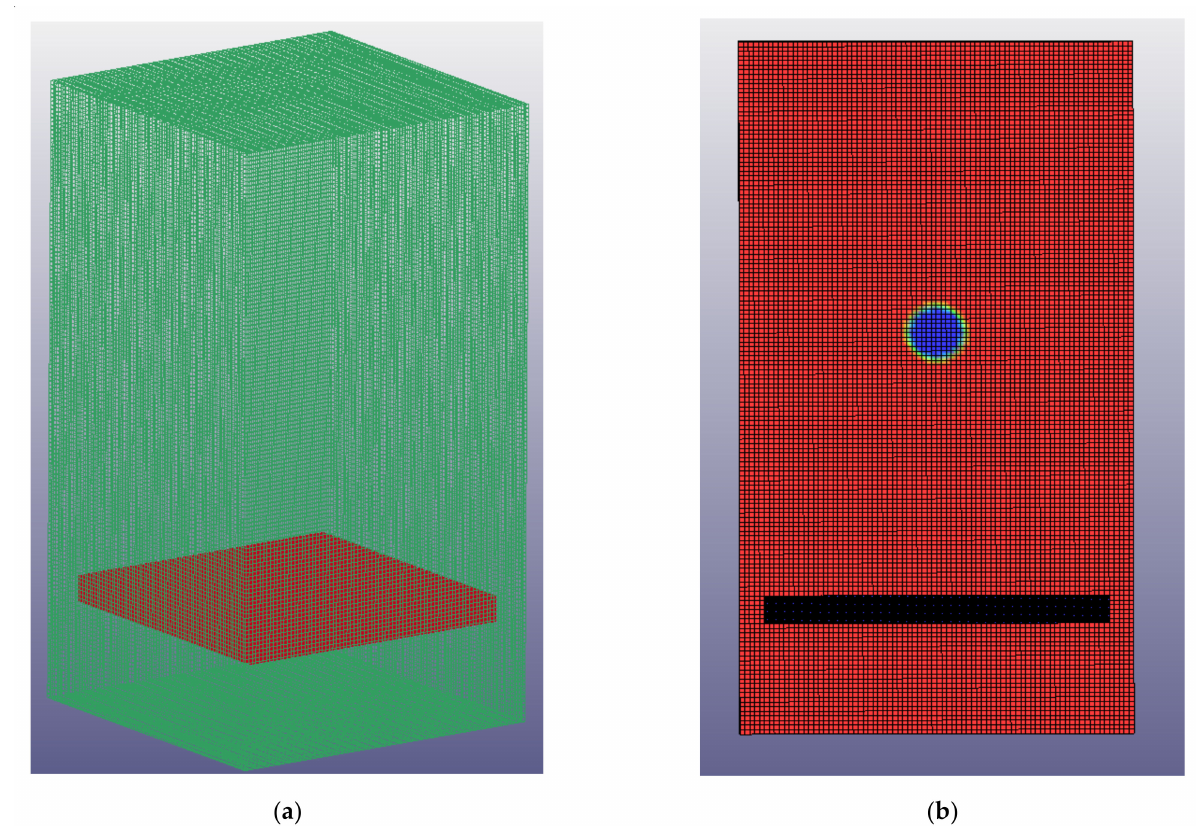
Figure 3. The ALE mesh of the dimensions 850 × 850 × 1400 mm: ( a ) Filled with air (green) encapsulating the meshed slab (red); ( b ) Filled with explosive material (blue) in the 600 mm distance from the slab (black).